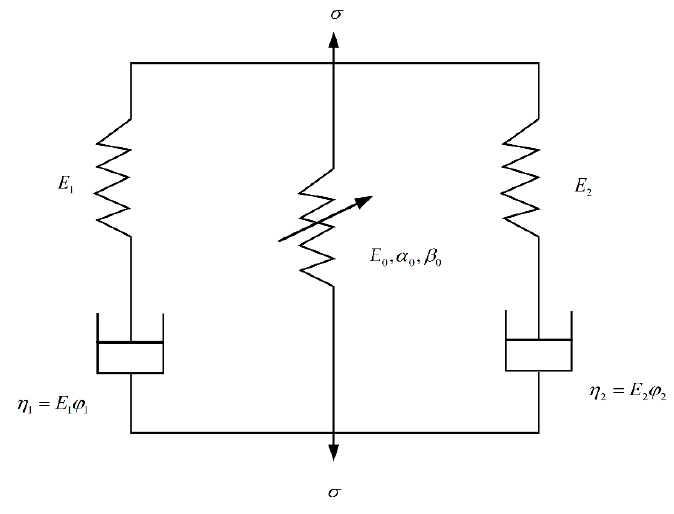
Figure 11. Z-W-T model. Figure 11. Z-W-T